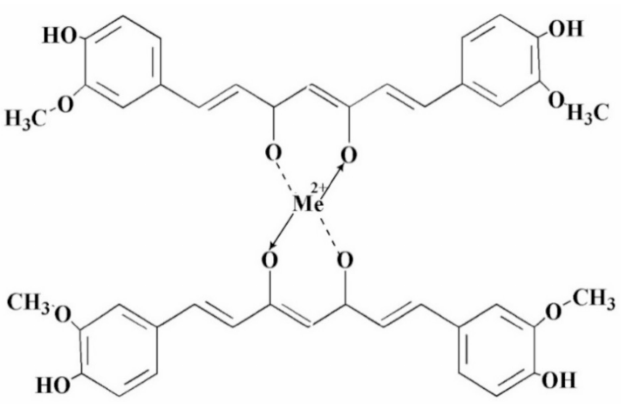
Figure 3. The theoretical structure of the curcumin/metal ions